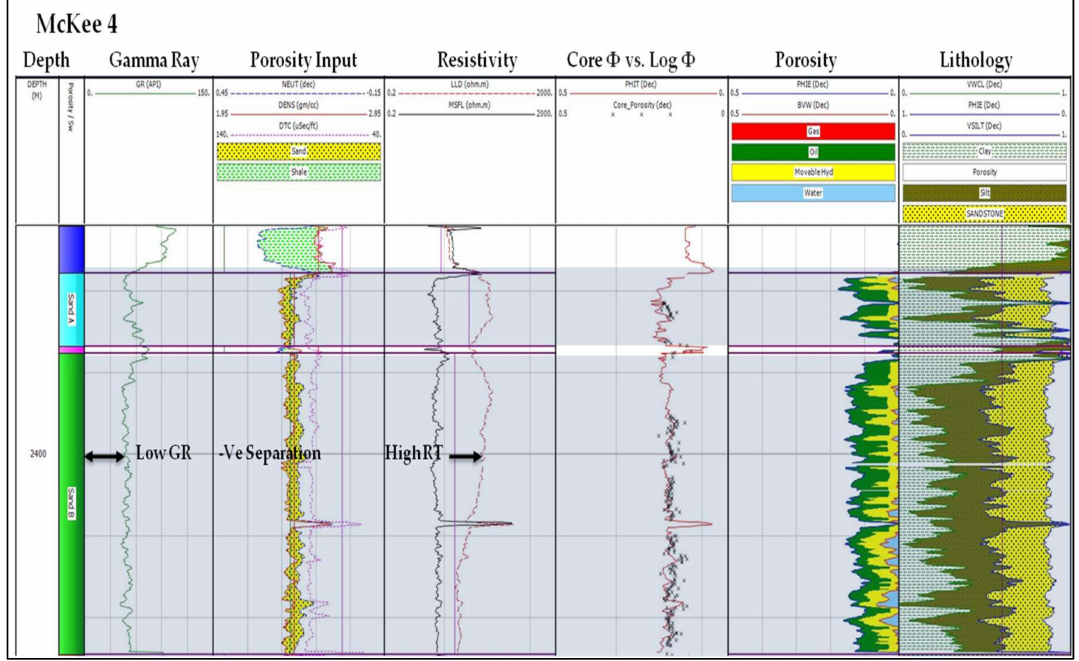
Figure 9. Litho-saturation plot of McKee 4. GR: Gamma Ray; -Ve Separation: Negative Separation; RT: High